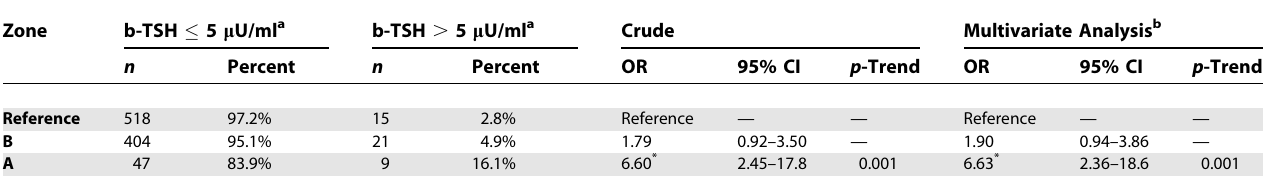
Table 3. Frequency and Relative Odds of Elevated Neonatal b-TSH Levels ( . 5 l U/ml) in Children Born between 1994 and 2005 to Women from Zone A (the Zone Most Contaminated after the Seveso Accident), Zone B, and the Surrounding Noncontaminated Area